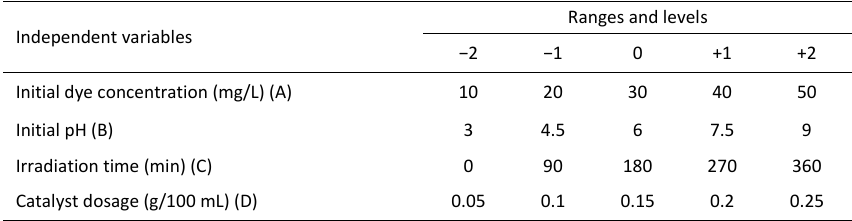
process of AO10 removal 4 Ranges and levels